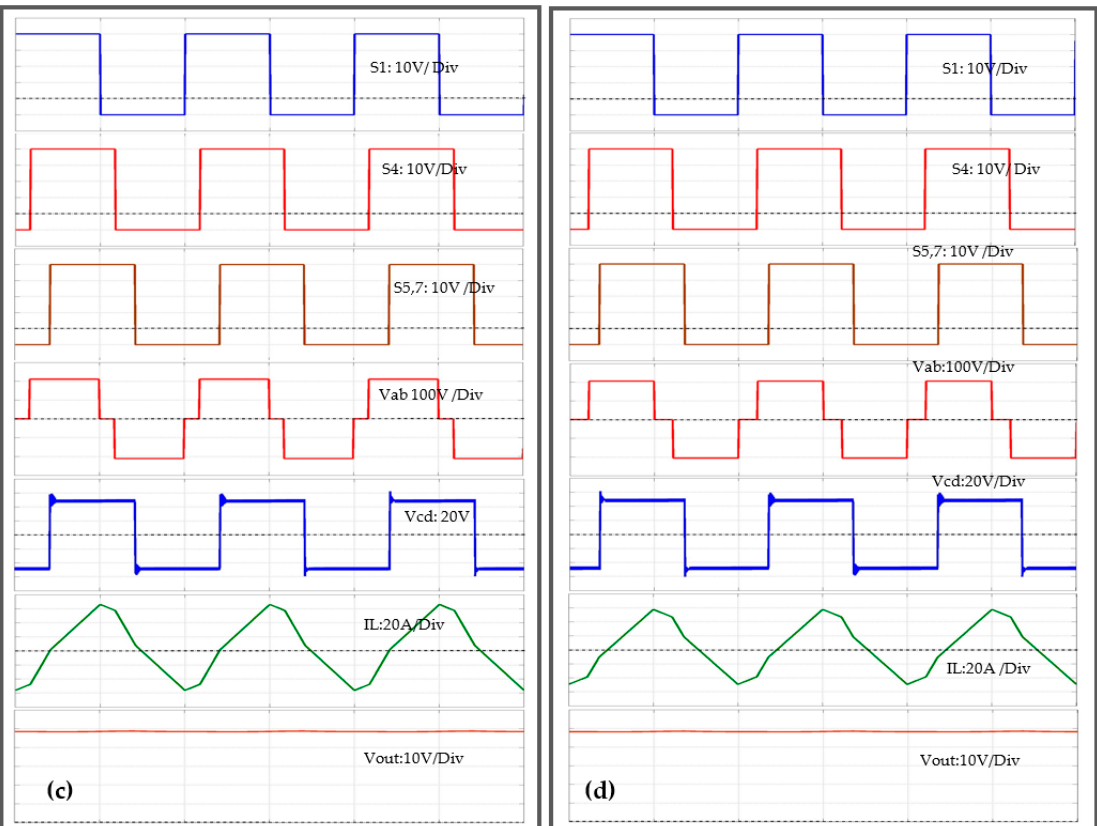
Figure 13. Blended SPS-ESPS control DAB-IBDC conversion waveform for a different input power that ( a ) 2000 W, ( b ) 1900 W, ( c ) 1700 W and ( d ) 1400 W. Time scale 5 ms/Div.